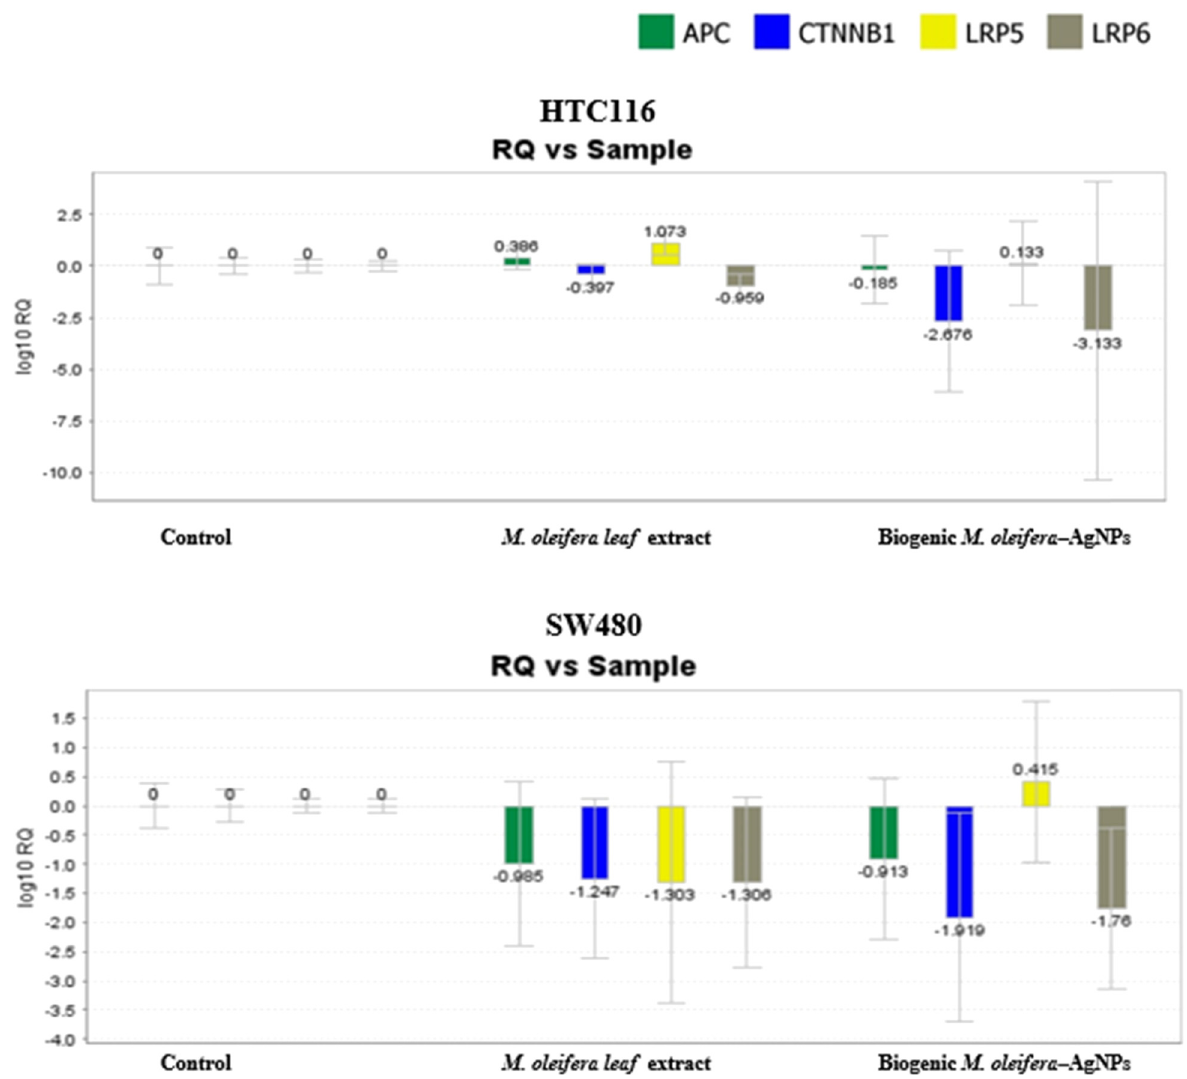
Figure 7: Gene expression in HTC116 and SW480 and cell lines treated with M. oleifera leaf extract and green - synthesized M. oleifera –